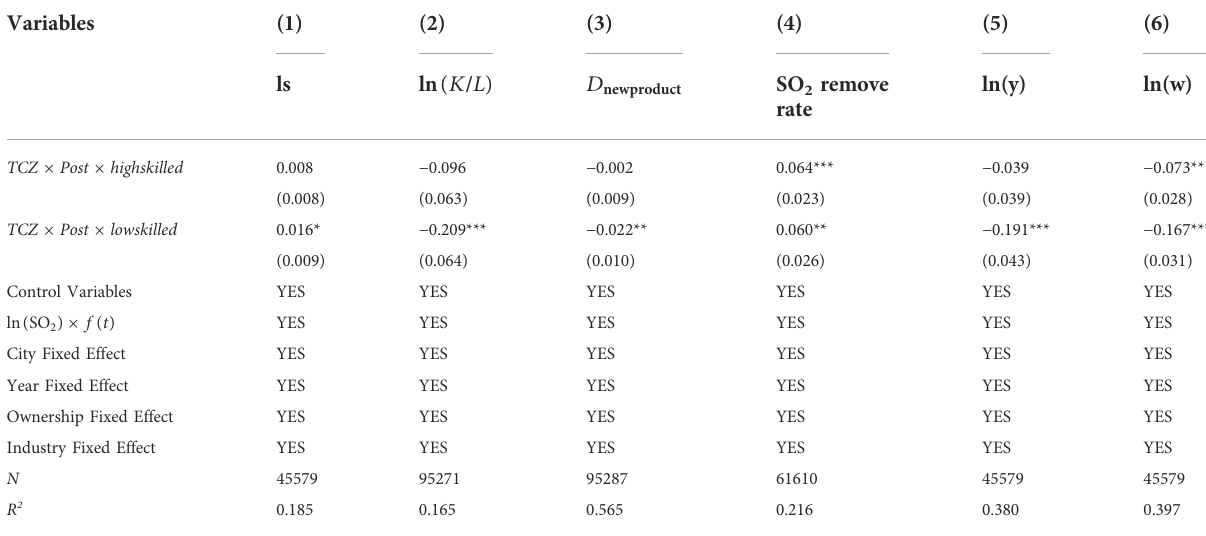
TABLE 7 Heterogeneous effects by workforce